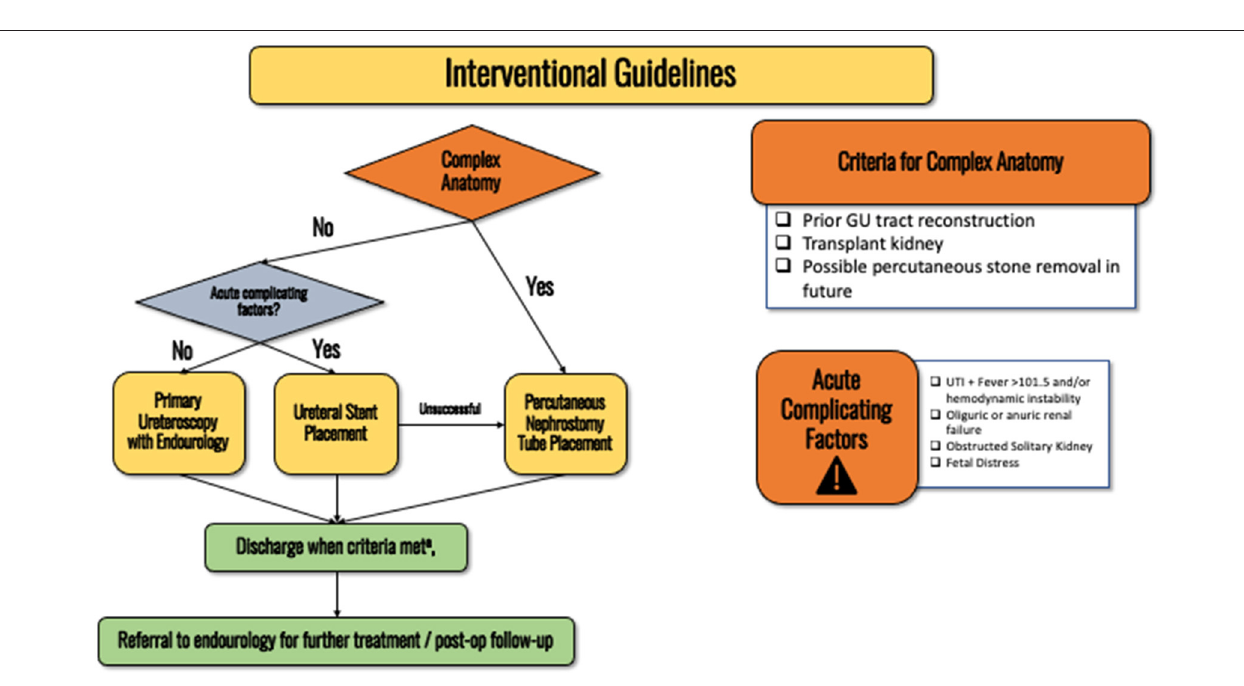
stent placement so IR can proceed with the PCN placement without requiring emergence from anesthesia for the patient to obtain another consent. If the patient refuses to have radiation